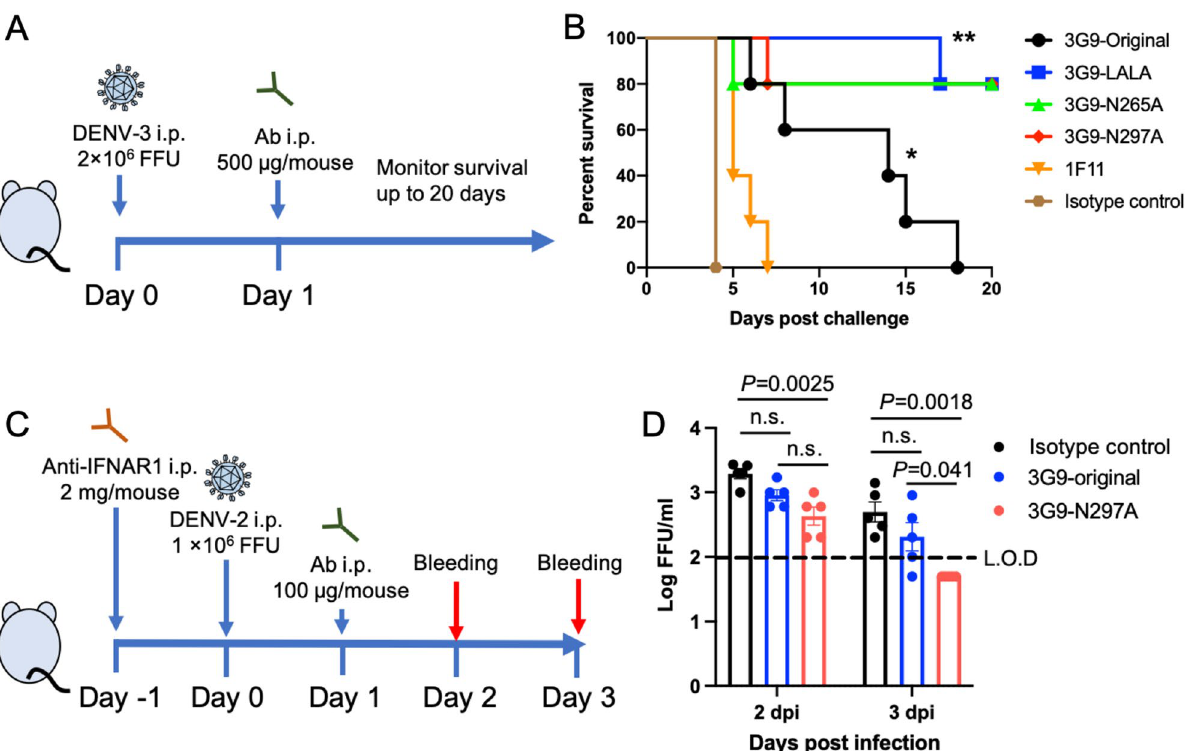
Figure 5. In vivo efficacy test. ( A ) Scheme of the animal challenge experiment using IFN-α/β/γR KO C57BL/6 mice. ( B ) Survival of infected mice after viral challenge. A group of five mice were infected with 2.0 × 10 6 FFU of DENV-3. Statistical significance was analyzed using a log rank test. * P < 0.01 for the comparison between isotype control and 3G9-original. ** P < 0.05 for the comparison between 3G9-original and the Fc-modified 3G9. There was no significant difference among the Fc-modified 3G9 ( P > 0.05). ( C ) Scheme of the animal challenge experiment carried out using immunocompetent BALB/c mice. ( D ) Viremia levels of the infected mice after the viral challenge. A group of five mice were infected with 1.0 × 10 6 FFU of DENV-2. The limit of detection (L.O.D) was 100 FFU/ml. Viremia levels below the detection limit are plotted as half of the detection limit (50 FFU/ ml). Statistical significance was analyzed using a one-way ANOVA. P < 0.05 was considered significant. n.s. not